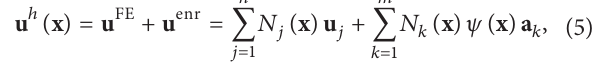
Figure 9: Tensile properties of epoxy resin as a function of nanoparticles (SiO 2 )